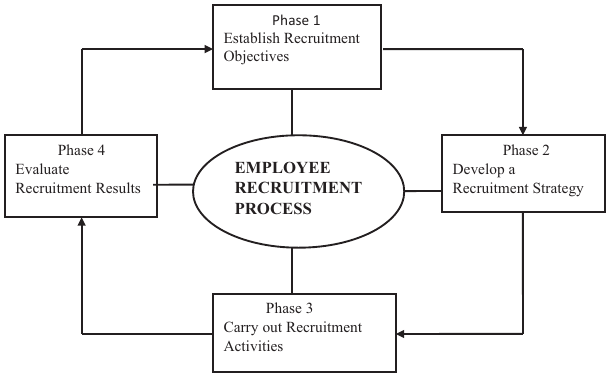
Figure 1. Employee recruitment